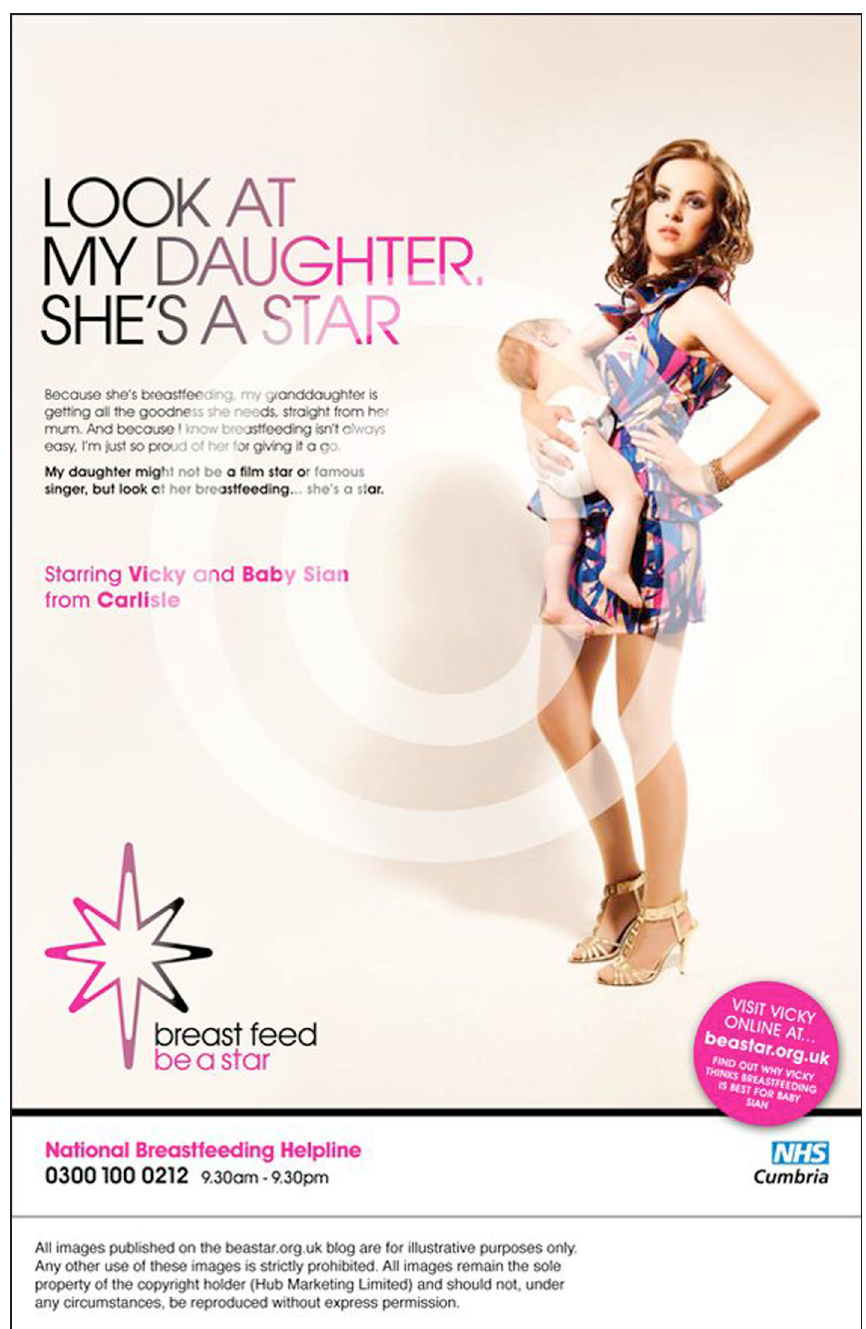
Figure 5: Be a Star campaign poster (NHS